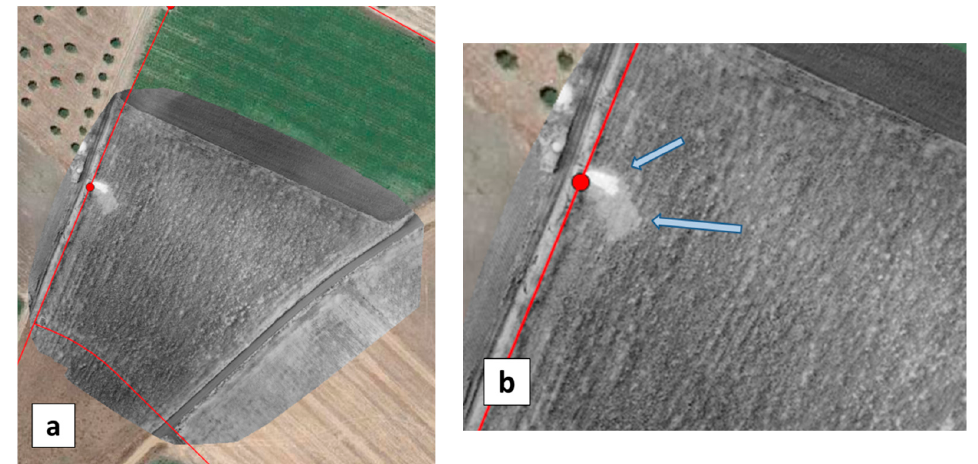
Figure 13. WI images obtained with the UAV on 14 May 2019 over the test field containing hydrant H11, ( a ) before and ( b ) after the vane was opened to simulate a leak; ( c ) is a close ‐ up over the hy ‐ drant area. The WI images are in greyscale (white for wet and black for dry), the water network is overlaid in red and Goggle Earth data (in color) fill the surrounding area. Covered area is about 130 m × 240 m. The contrast between wet and dry soil is very high.